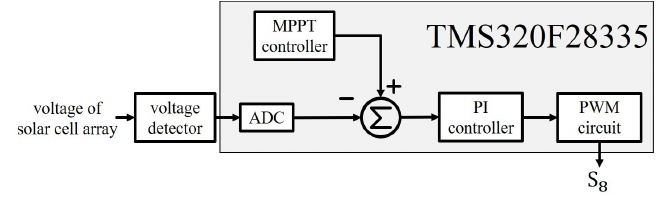
Figure 10. Control block diagram of the DDC.